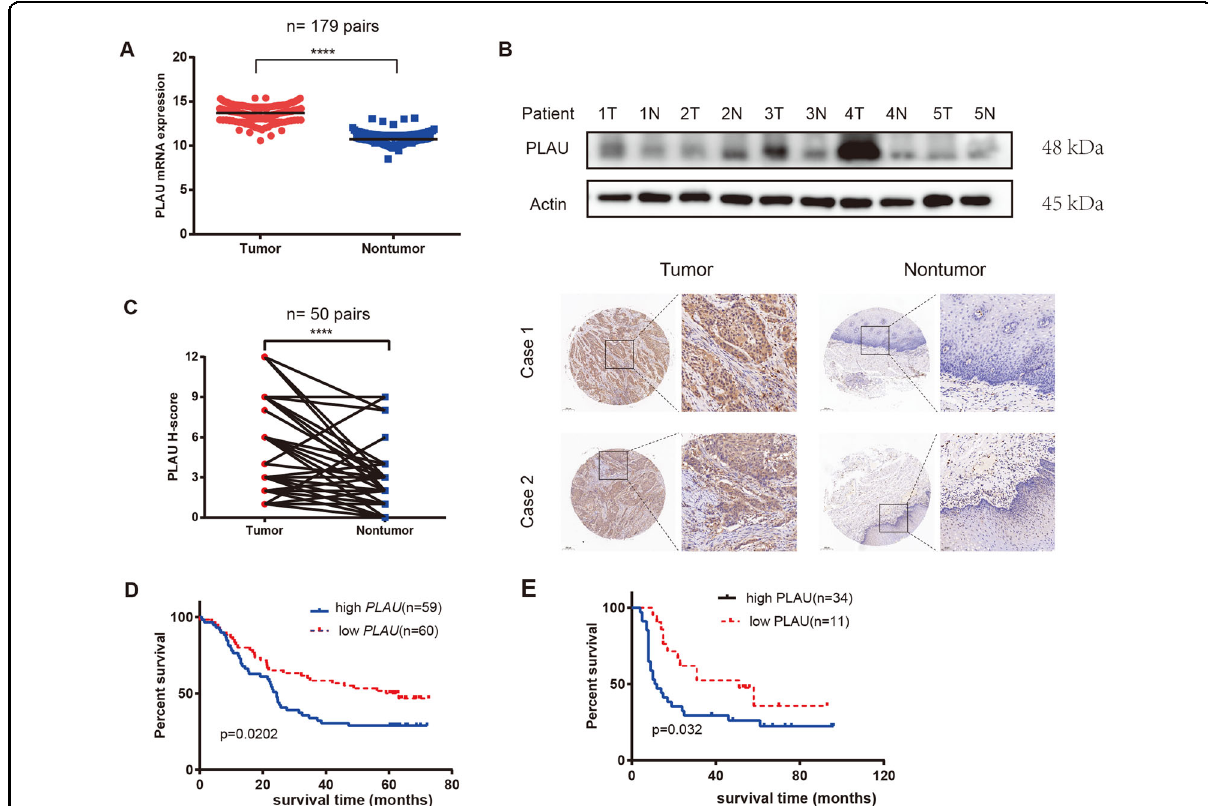
Fig. 1 High PLAU expression indicates a poor prognosis in ESCC tissue. A , B PLAU was more highly expressed in cancer compared with para- cancer tissues at the RNA ( A , GSE53625) and protein ( B , C ) levels, B western blot analysis of tumor and adjacent nontumor tissues from fi ve patients, and C immunohistochemistry (IHC) scores (left) and representative images (right) of PLAU staining in ESCC tumor tissues and nontumor tissues (original magni fi cation: 50×, 200×). D , E Kaplan – Meier survival analysis of overall survival based on high ( n = 89) and low ( n = 90) PLAU expression in GSE53625 (D) and high ( n = 34) and low ( n = 11) PLAU expression by IHC ( E ). * P < 0.05, ** P < 0.01, *** P < 0.001, **** P < 0.0001 (Student ’ s t -test